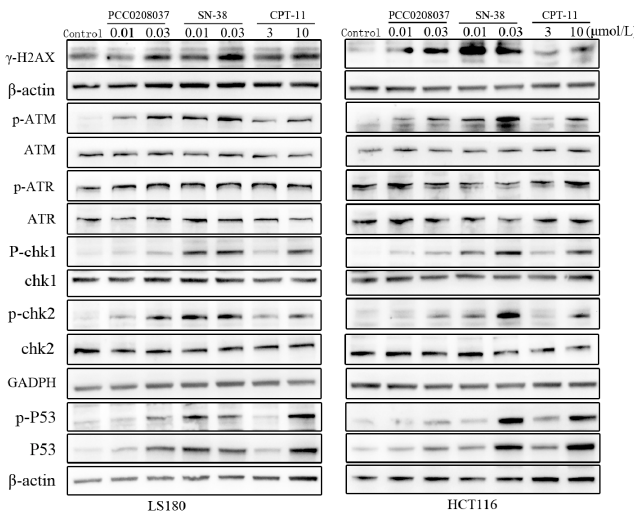
Figure 6. Effects of PCC0208037 on molecules related to DNA damage in CRC cells. Western blotting analysis was conducted to detect the expression of the battery of proteins that are known to be related to DNA damage, such as γ -H2AX, ATR, p-ATR, ATM, p-ATM, Chk1, p-Chk1, Chk2, p-Chk2, and p-P53 in HCT116 and LS180 cells treated with PCC0208037 (0.01 and 0.03 µM) for 8 h.